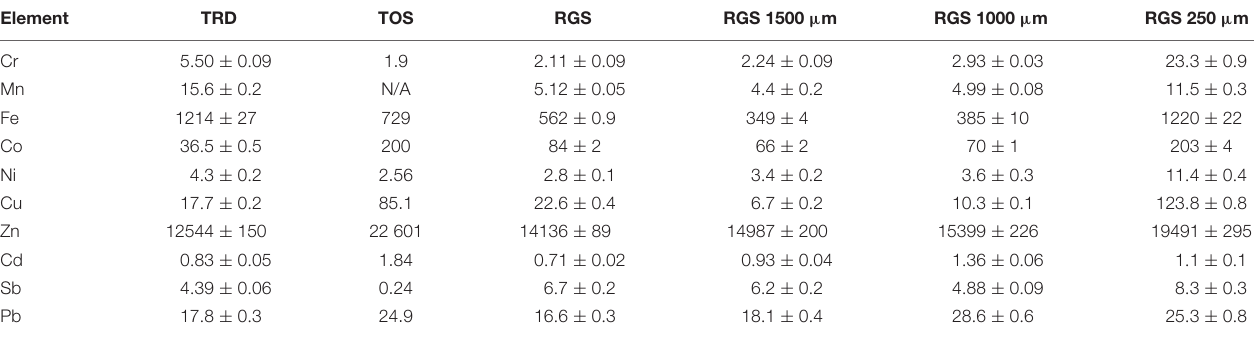
TABLE 3 | Concentrations of metals in CRG (mg kg − 1 ). Element